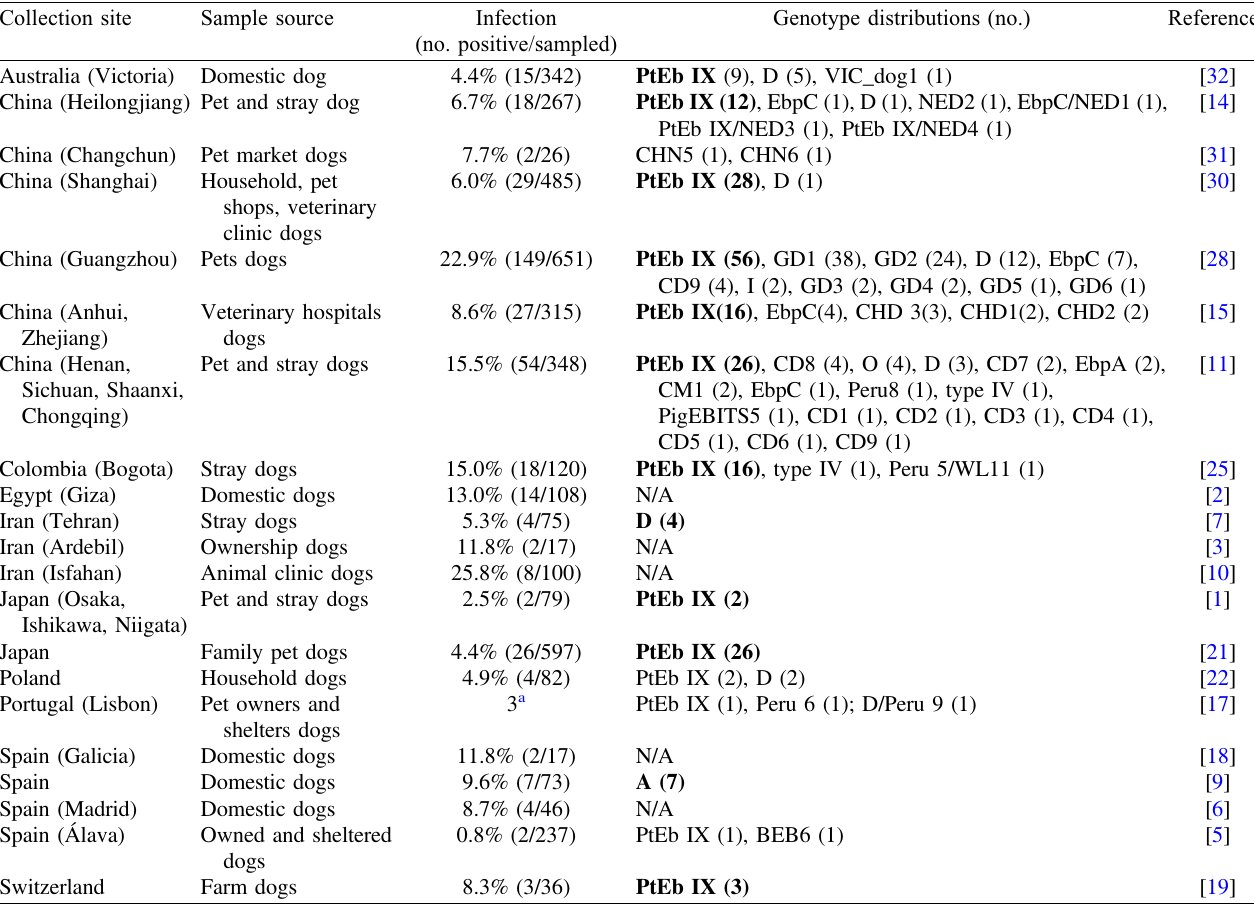
Table 2. Prevalence and genotype distributions of E. bieneusi in